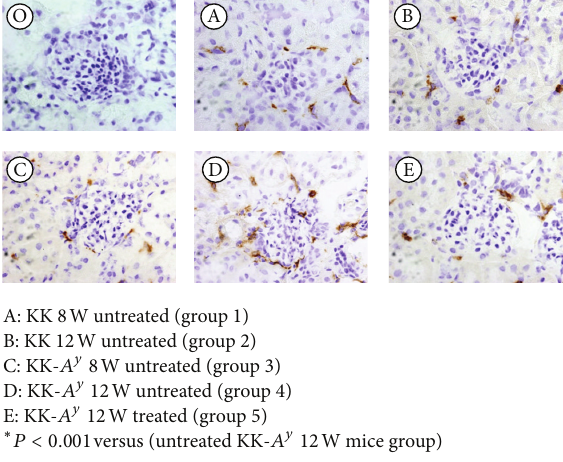
Figure 3: Number of F4/80 positive cells and staining of the renal sections of each mouse (O: untreated KK- 𝐴 𝑦 mice at 12 weeks of age without primary Ab, A: untreated KK mice at 8 weeks of age, B: untreated KK mice at 12 weeks of age, C: untreated KK- 𝐴 𝑦 mice at 8 weeks of age, D: untreated KK- 𝐴 𝑦 mice at 12 weeks of age, and E: treated KK- 𝐴 𝑦 mice at 12 weeks of age). The number of F4/80- positive cells was counted to determine the macrophage infiltration in each group. Macrophage infiltration increased significantly in group 4 as compared with groups 1, 2, and 3. This increase was attenuated in group 5 ( ∗ 𝑃 < 0.001 versus untreated KK- 𝐴 𝑦 mice at 12 weeks of age). Images were taken at 200-fold